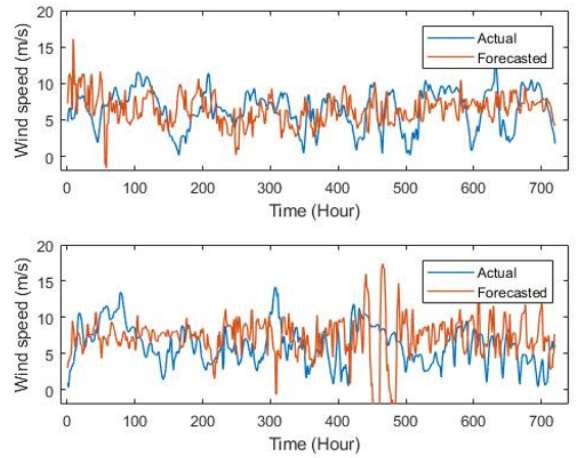
Figure 10. Time series response, Case 1. Table 1. Error metrics in Case 1.